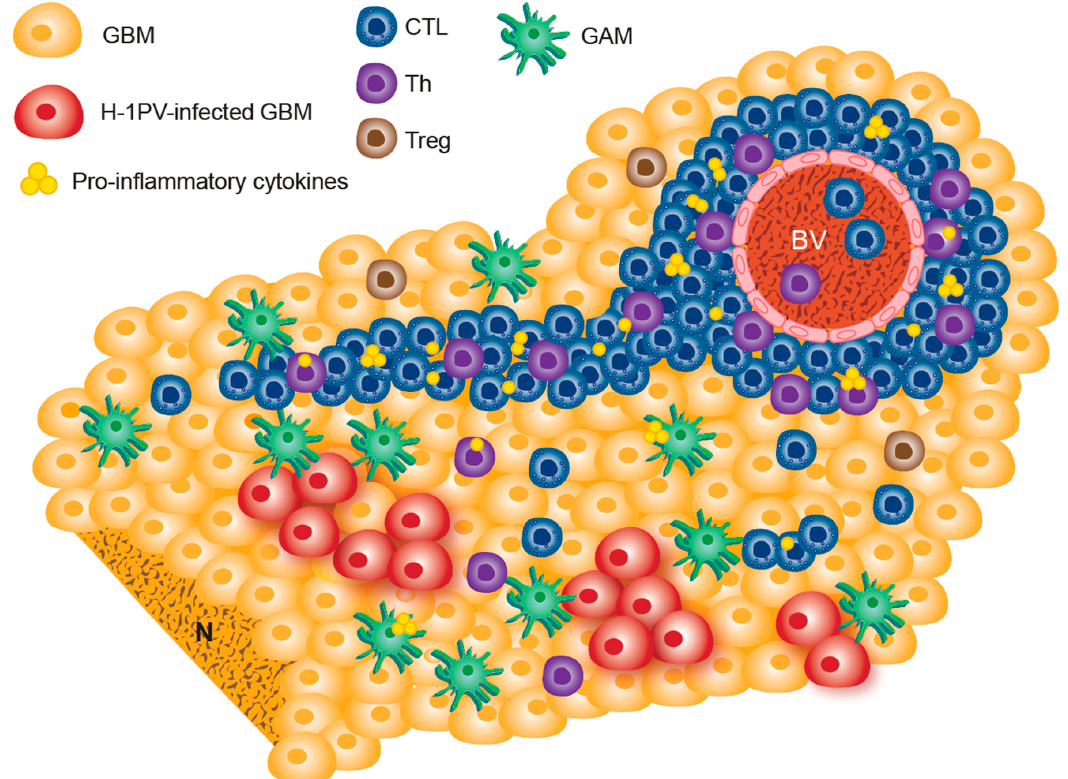
Figure 2. Tumor microenvironment immune landscape as identified in resected tumors from H-1PV-treated recurrent glioblastoma patients. Microglia/macrophage activation, diffuse and perivascular tumor infiltration with activated Th and cytotoxic T cells, and proinflammatory cytokine expression were observed in patient-derived tumor tissue sections. Only scarce Treg cells were present. H-1PV transcripts as well as the oncotoxic NS1 protein were detected in clustered tumor cells. For details and references, see [44,46] and main text. BV, blood vessel; CTL, cytotoxic T lymphocyte; GAM, glioblastoma-associated microglia/macrophages; GBM, glioblastoma; N, necrosis; Th, T helper; Treg, regulatory T cell.